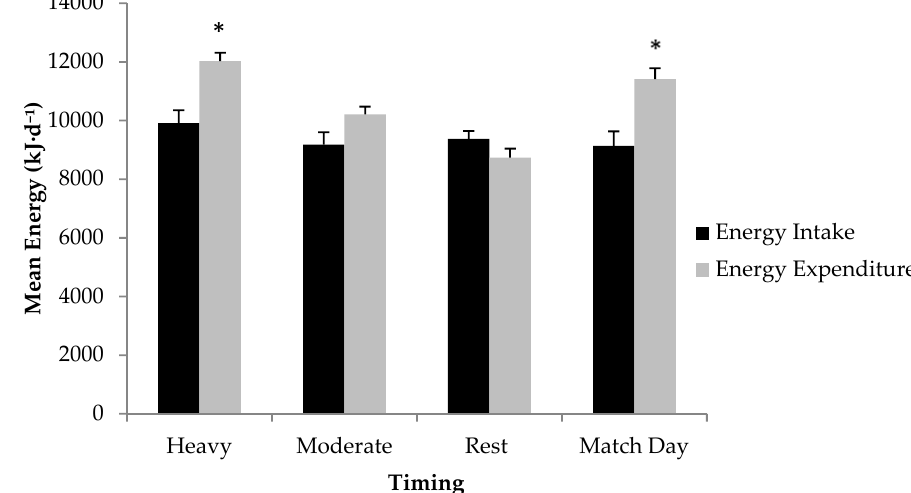
Figure 1. Mean Energy Intake (kJ) compared to Mean Energy Expenditure (kJ) for type of training. * Significant difference between mean energy intake and mean energy expenditure at the corresponding time-point at p < 0.05 level.